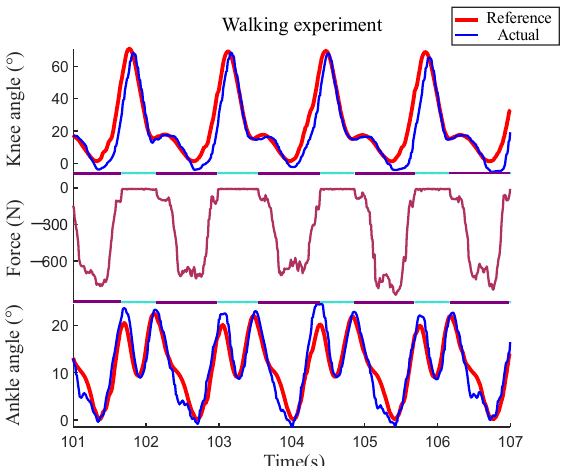
Figure 9. The results of walking experiment on treadmill. Force is the value of GRF and the downward direction is positive. The stance phase is marked with purple horizontal bars while the swing phase is marked with blueish green bars.